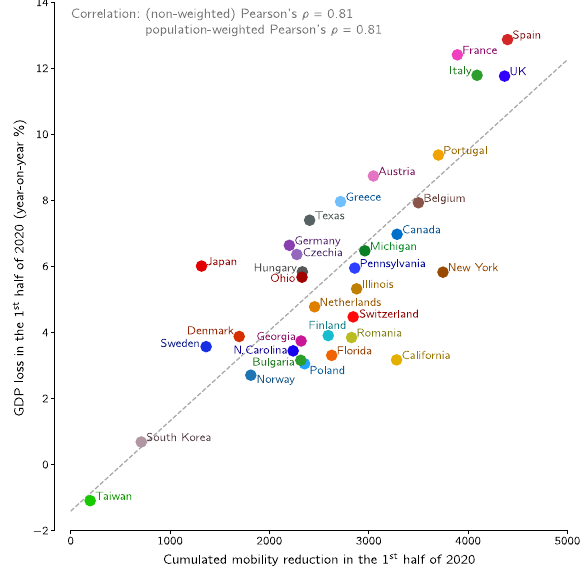
Figure 4. GDP loss in the first half of 2020 vs. cumulative lockdown in this period for European and East Asian countries, ten US states, and Canada.